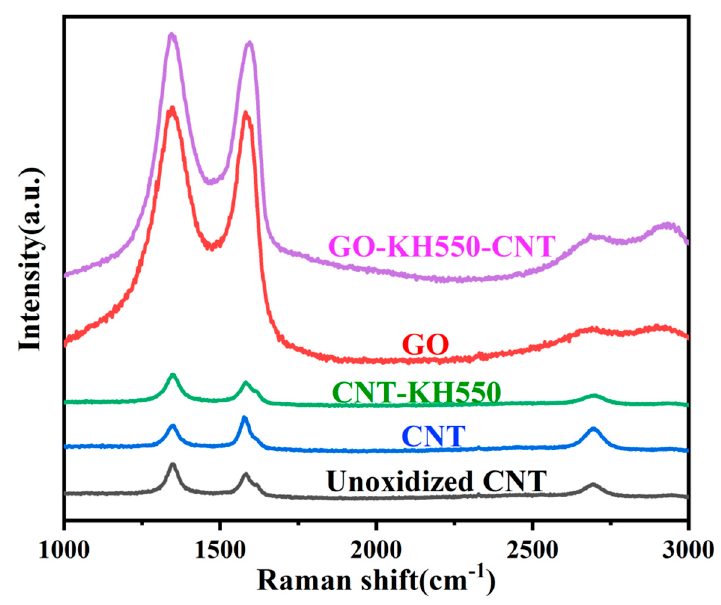
Figure 4. Raman spectroscopy (color figure can be viewed online).